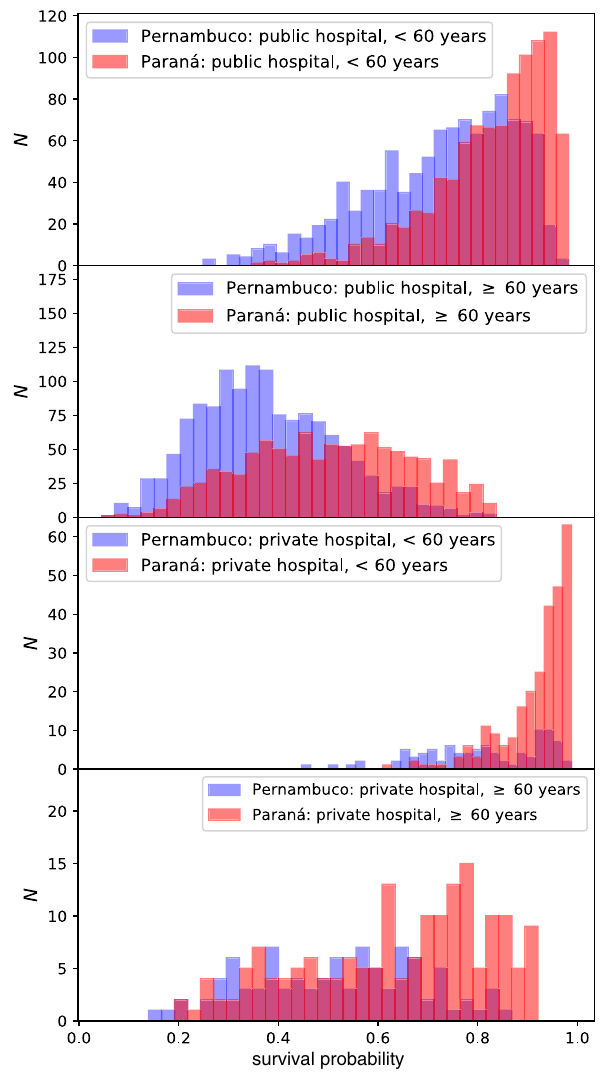
Figure 7. Distribution of survival probability—ranging from 0 (death) to 1 (recovery)—as estimated by the XCOVID-BR model. We contrast typical publicly and privately funded hospitals from Pernambuco, an example of a region in the more socioeconomically challenged Northeast, with examples from the richer Paraná region in the South. Stratifying by age, the dominant clinical predictor of mortality, it is apparent that the probability distribution is skewed with lower mortality in the wealthier (Paraná) region and this is particularly apparent in younger patients and in privately-funded